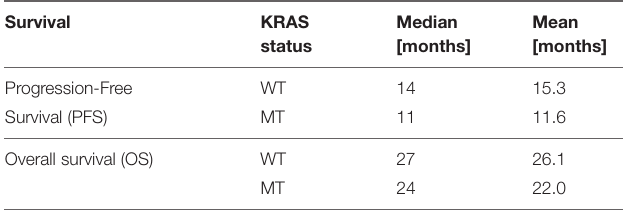
TABLE 3 | Median and mean survival time.